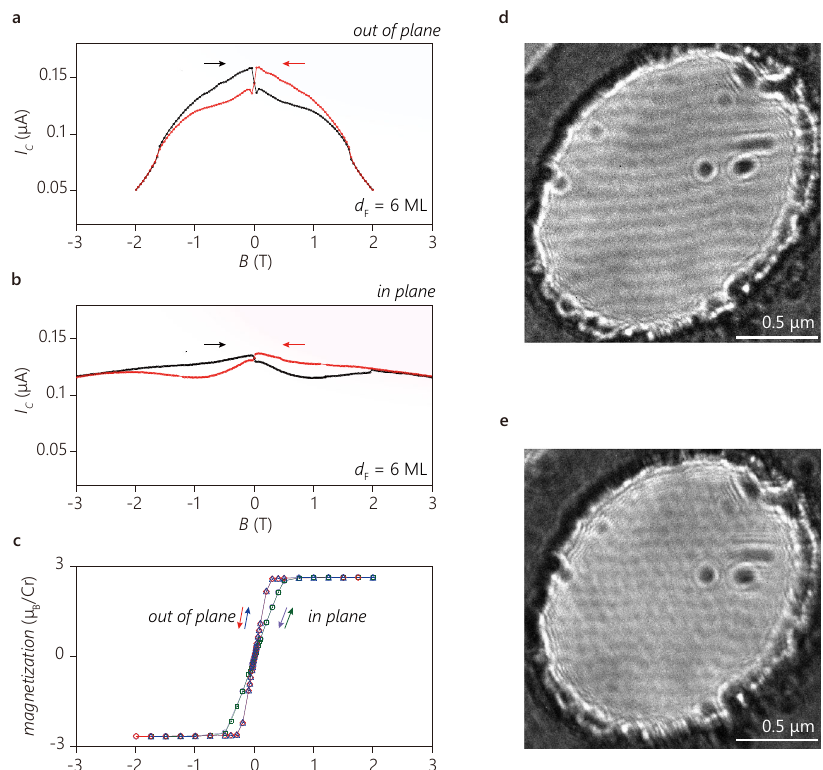
Fig. 2 The magnetic characteristics of the Josephson Junction and Cr 2 Ge 2 Te 6 . a , b The switching current of the NbSe 2 /Cr 2 Ge 2 Te 6 /NbSe 2 junction with a 6 ML Cr 2 Ge 2 Te 6 barrier at the temperature of 0.3 K as a function of the applied magnetic fi eld ( a ) perpendicular ( b ) and parallel to the 2D layer. The red lines indicate the magnetic fi eld scan from positive polarity to negative polarity and the black ones from negative polarity to positive polarity. c The bulk magnetization of a Cr 2 Ge 2 Te 6 crystal measured by a SQUID magnetometer at 4 K. The red diamonds and blue triangles indicate the data with perpendicular fi eld, and the purple circles and green triangles indicate the data with in-plane fi eld. The arrows indicate the sweep direction for ( a – c ). d The magnetic domain structure of a Cr 2 Ge 2 Te 6 fl ake measured by Lorentz microscopy without an applied magnetic fi eld. The thickness of the fl ake is 18 nm. The sample was tilted by 45° from the incident electron beam direction to image an out-of-plane magnetization pattern at the temperature of 25 K. The black and white contrast in the central oval-shape area indicates magnetic domain wall contrast caused by the opposite magnetization. The oval-shape is the area where Cr 2 Ge 2 Te 6 is suspended over a hole in the SiN membrane support. e Lorentz micrograph of the same sample with ( d ) but taken with a different thermal cycle. Unlike the simple stripe domains shown in ( d ), bubble-like domains appear to break up the stripe-like domains. The scale bars correspond to 0.5 μ